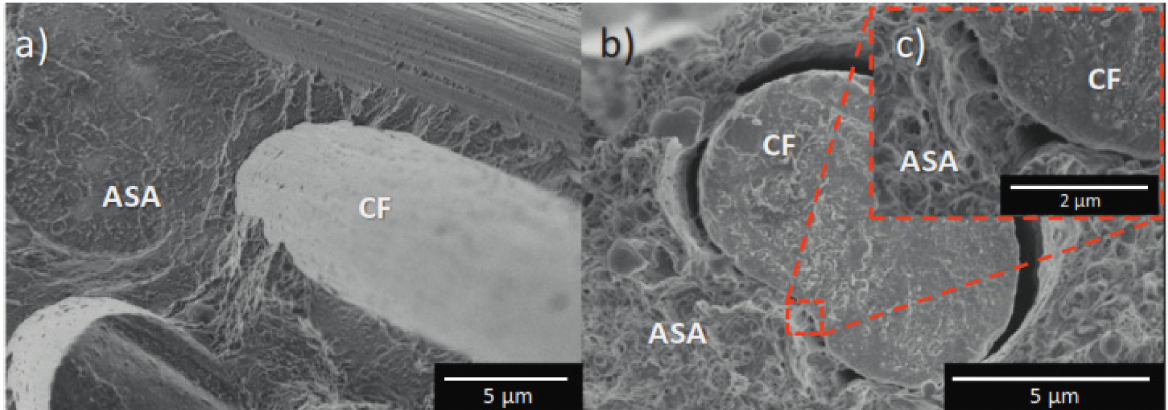
Figure 2. ( a ). SEM images showing flexural fracture at lower temperatures, ( b ). Tensile tested specimen, ( c ). Details of interface between carbon fiber and ASA [4] Copyright 2020 with permission from Elsevier.